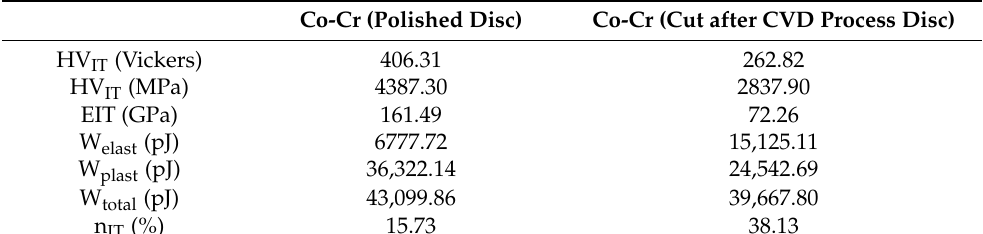
To determine the quality of Co-Cr disc surface, the scratch tests were performed for polished and cut samples. The pictures of the surface obtained for the investigated mate- rials are presented in Figure 10.